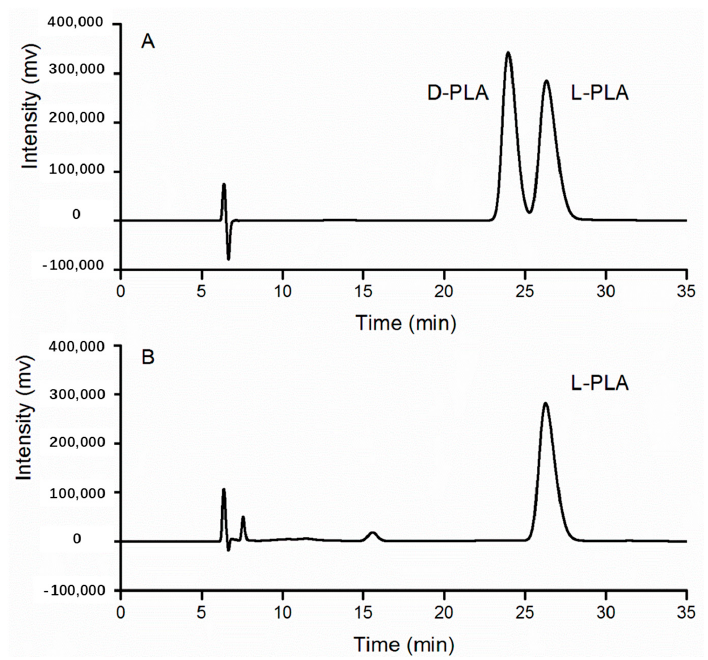
Figure 6. HPLC chiral analysis of PLA produced by whole cells of E. coli pETDuet-ldhL-gdh. ( A ) Standards of L-PLA and D-PLA; ( B ) Sample of conversion.